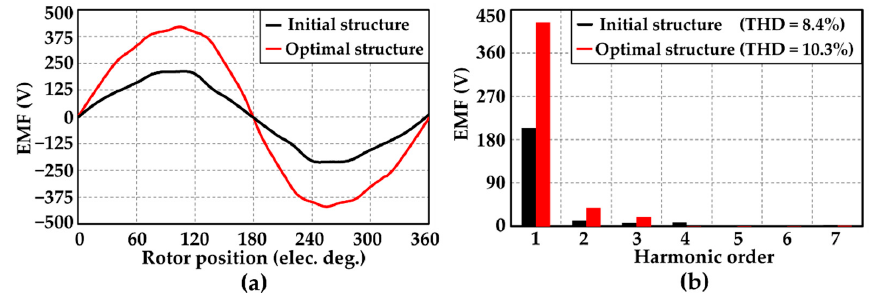
Figure 9. Comparison of ( a ) back-EMF waveforms and ( b ) contributing spectrum.